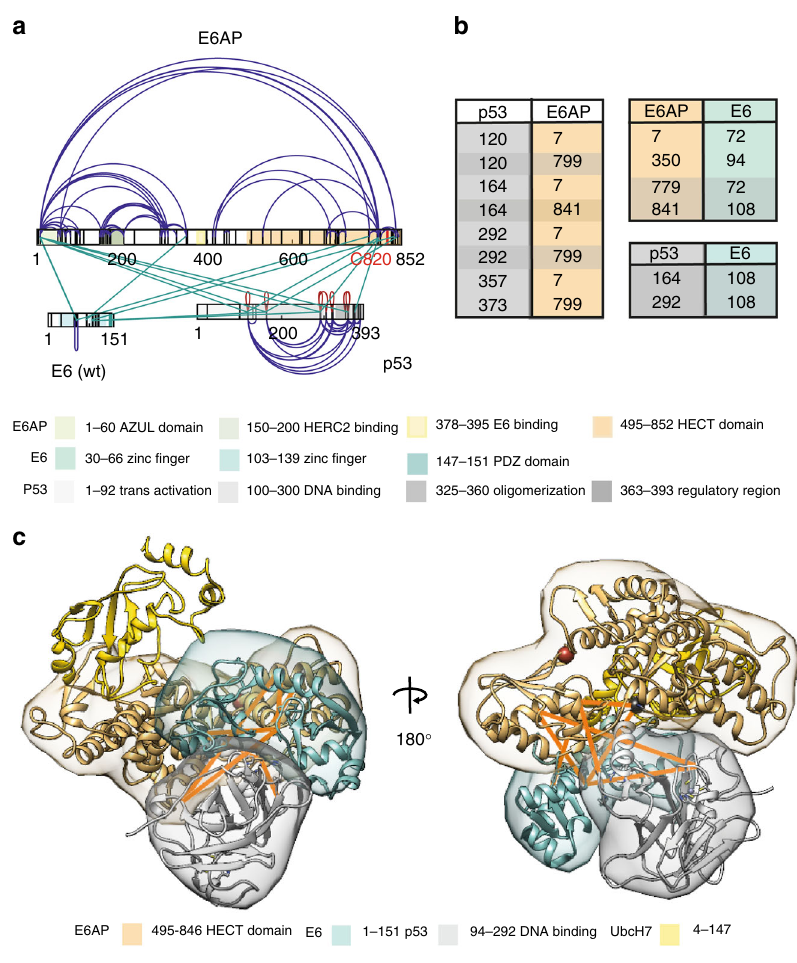
Fig. 4 Distinctive binding sites within the E6AP – E6 – p53 complex. a Shown are the identi fi ed interlinks between E6AP, E6, and p53. Lysine residues and regions of known functions within E6AP and E6 are color-coded as in Fig. 1. Functional domains in p53 — transactivation domain, DNA binding domain, oligomerization domain and regulatory region — are shown in signal white, gray white, telegrey, and white aluminum, respectively. Crosslinks between sequence identical peptides that are bijective within the particular protein sequence are shown as red loops. b List with identi fi ed interlinks between p53, E6AP, and E6. Numbering is according to human E6AP isoform 1 33 . Links which can be mapped to existing PDB structures (4XR8; 1C4Z) are highlighted. c Structural model of the binding interface between the HECT domain of E6AP, E6, and p53. The localization densities of the HECT domain of E6AP (residues 495 – 846), E6 (residues 1 – 151), and p53 (residues 94 – 292) are shown in sand yellow, light green, and telegrey, respectively, with a single representative ribbon structure embedded. For clarity, UbcH7, a cognate E2 of E6AP was also added and is shown in yellow (PDB: 1C4Z). Detected interlinks between E6, p53, and E6AP that map to PDB structures 4XR8 and 1C4Z, respectively, are highlighted in orange. The catalytic cysteine at position C820 in the HECT domain of E6AP is shown as a red ball. Residue K292 of p53 (most C-terminal lysine residue in the model) is shown as a gray ball. The model is shown from a side view (left), using the exact same view as in Fig. 3 right panel, and rotated around its axis